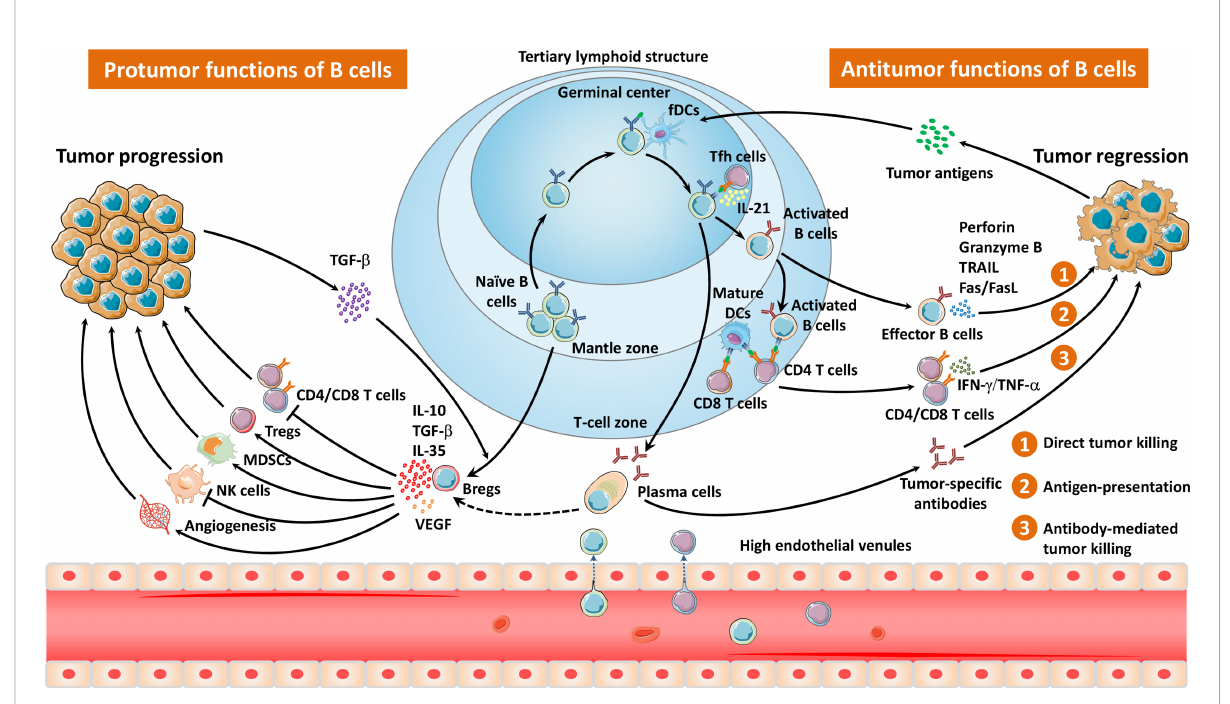
FIGURE 1 The migration pathways and diverse properties of TLS- and non-TLS-associated B cells in the TME. Naïve B cells are recruited and in fi ltrate into the TME via HEVs, mainly locating in the mantle zone of TLSs. After exposure to tumor antigens within the GCs, B cells interact with follicular helper T cells as well as follicular dendritic cells, and undergo a series of biological events, including clonal expansion, somatic hypermutation, class switching, and tumor-speci fi c antibody production. Effector B cells or plasma cells elicit antitumor responses via direct tumor killing, antigen presentation, and antibody-mediated tumor cell lysis. In contrast, Bregs impair antitumor immunity through immunosuppressive cytokines, which inhibit the activity of T cells as well as NK cells, and induce Tregs, MDSCs, and